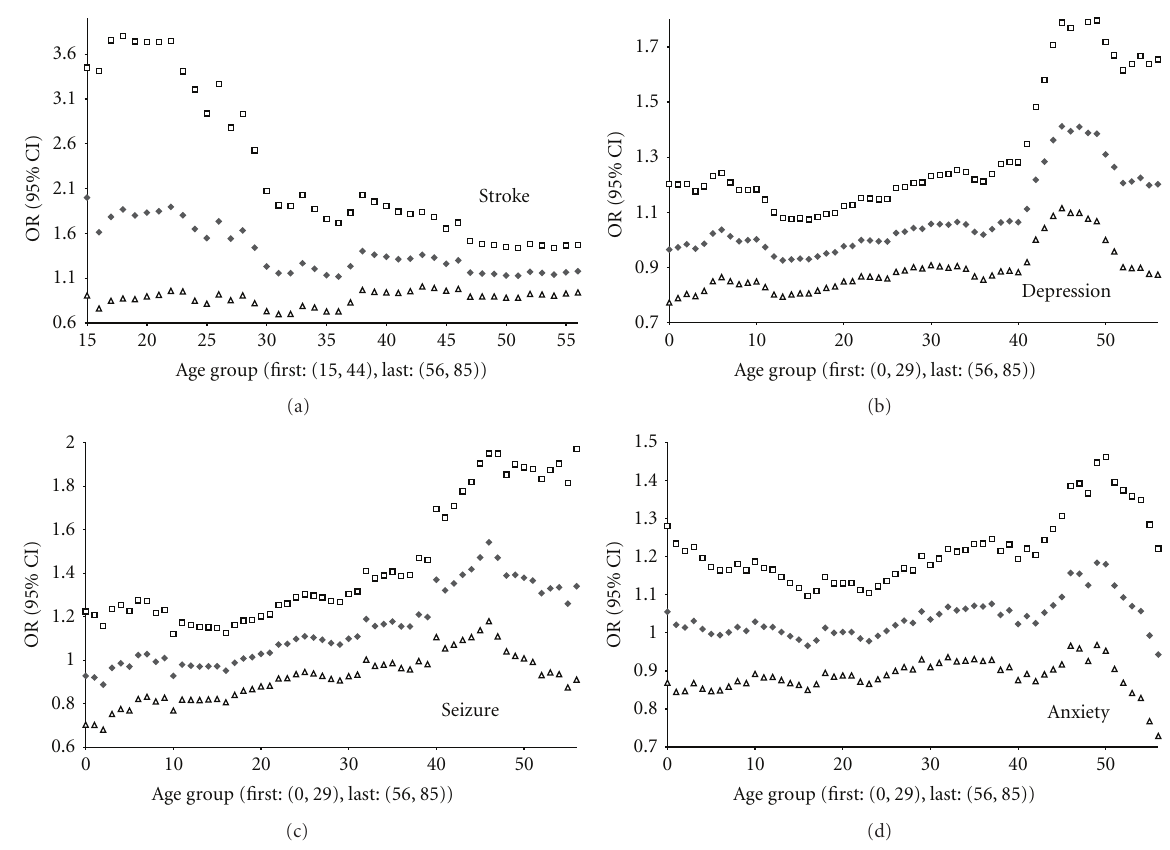
Figure 3: Odds ratios for female ED visits for stroke, seizure, depression and anxiety associated with exposure to SO 2 — by age